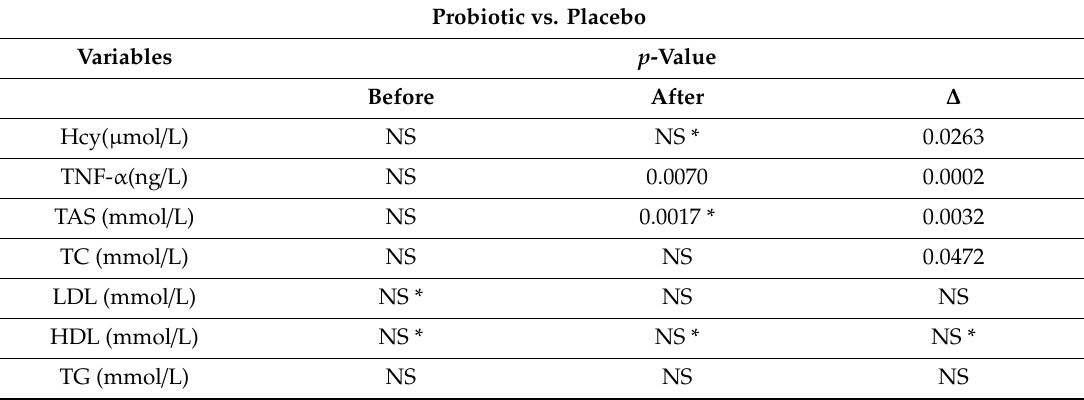
Table 3. Comparative analysis of Hcy, TNF- α , TAS level and the lipid profile parameters between the probiotic group and the placebo